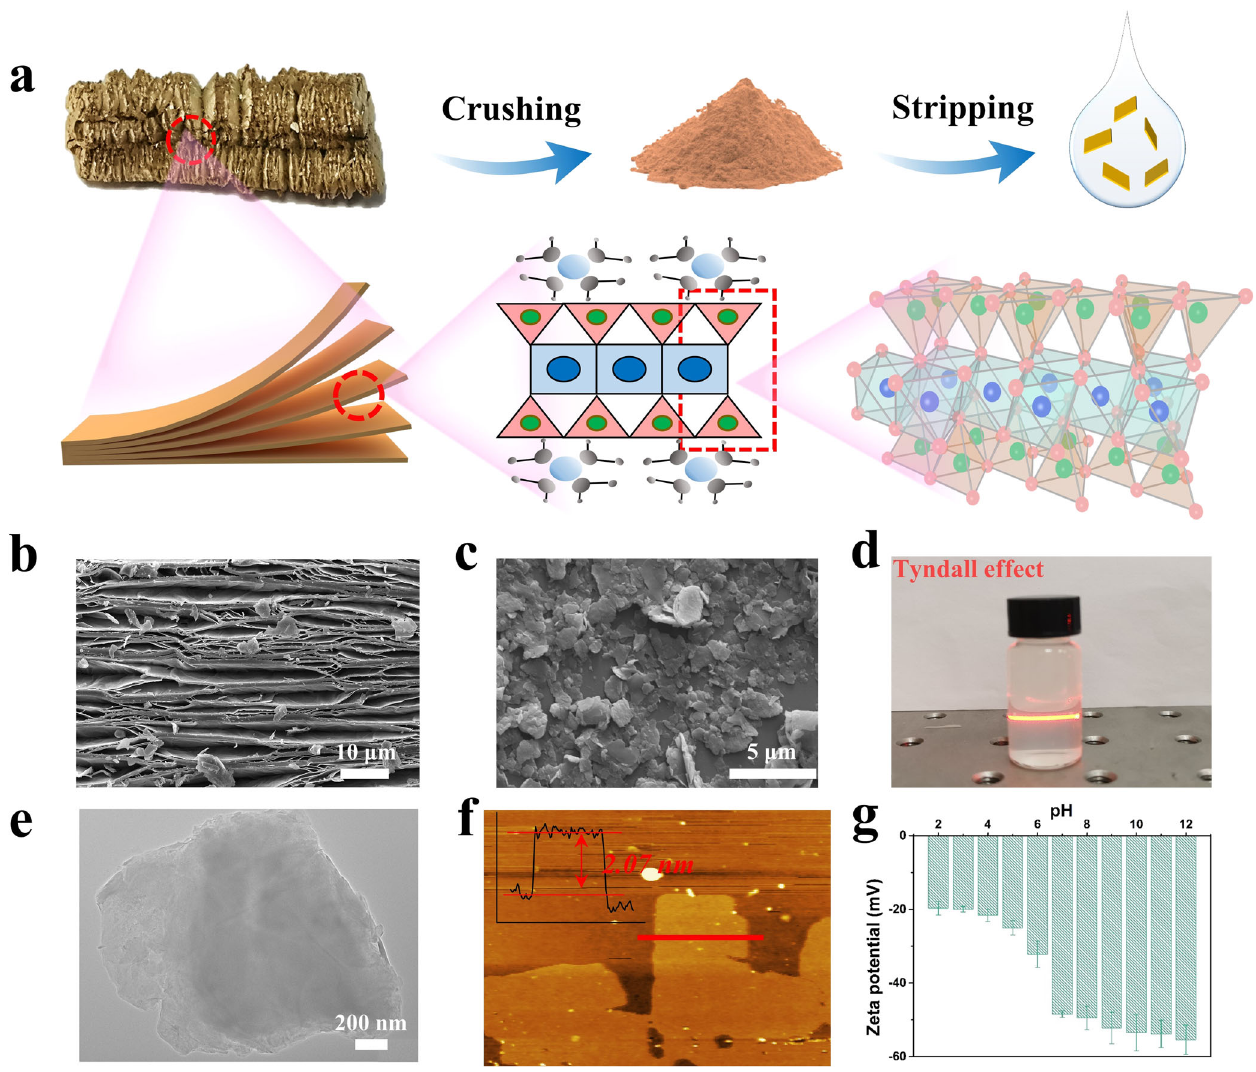
Fig. 1 Exfoliation of phyllosilicate nanosheets. a Schematic diagram of the exfoliation process of VMT nanosheets from expanded VMT with accordion-like morphology and the corresponding crystal structure of VMT. b SEM image of the expanded VMT crystal. c SEM image of the exfoliated VMT nanosheets. d Photograph of the VMT nanosheet solution, showing Tindal effect. e TEM image of the exfoliated VMT nanosheets. f AFM image and the corresponding height pro fi le of the exfoliated VMT nanosheets. g Zeta potentials of the VMT dispersions at different pH